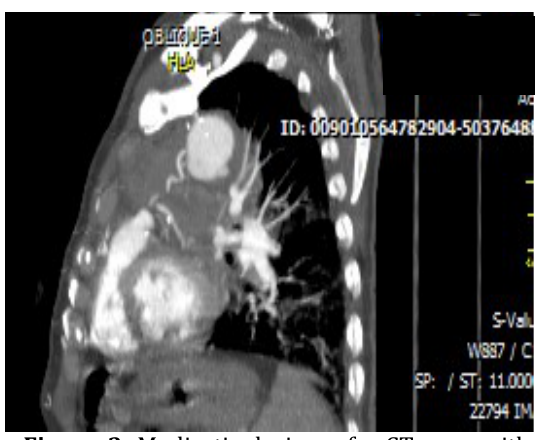
Figure 3 . Mediastinal view of CT scan with contrast